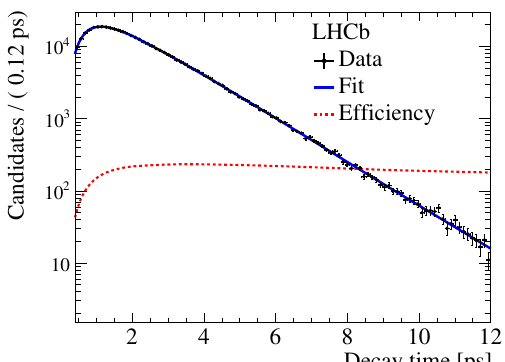
Figure 3 . Background-subtracted decay-time distribution for tagged candidates. The solid blue curve is the projection of the signal PDF. The red dotted curve indicates the e(cid:14)ciency function " ( t ) in arbitrary units.